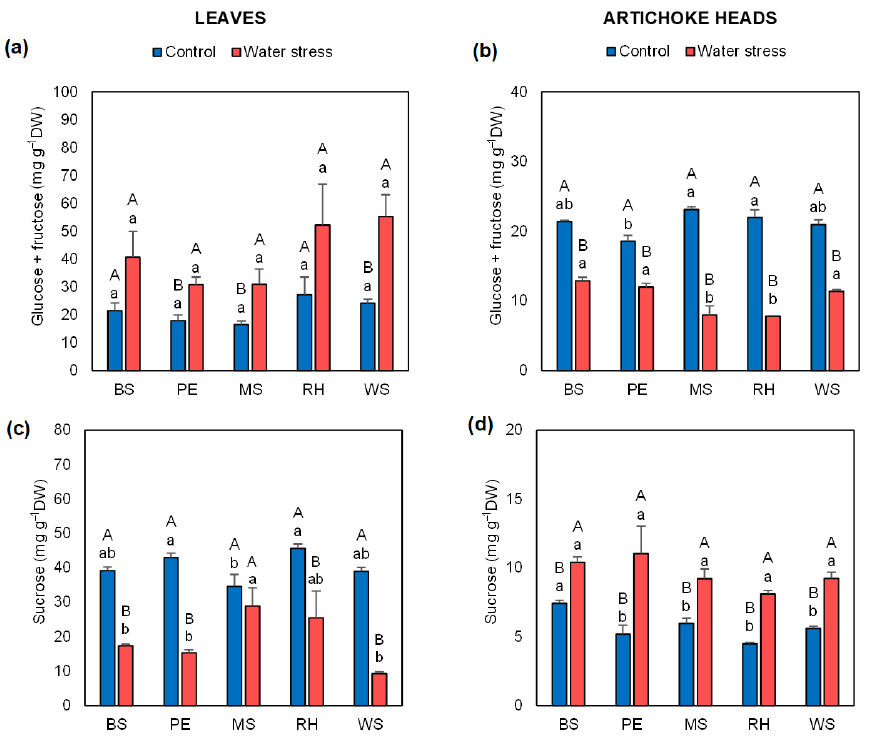
Figure 2. Hexose (glucose + fructose) concentrations in ( a ) leaves and ( b ) heads, and sucrose concentrations in ( c ) leaves and ( d ) heads of artichoke plants of the commercial Symphony variety non- mulched or subjected to different mulching treatments and cultivated under control (well-watered) and water-stress (70% ETc) conditions. Bars show the means of five plants ± standard error. Different capital letters indicate significant differences due to the water-stress treatment, while different small letters show significant differences among mulching treatments according to Tukey’s test ( p ≤ 0.05). Abbreviations used: bare soil (BS), polyethylene mulch (PE), mushroom-substrate-based hydromulch (MS), rice-hull-based hydromulch (RH), and wheat-straw-based hydromulch (WS).